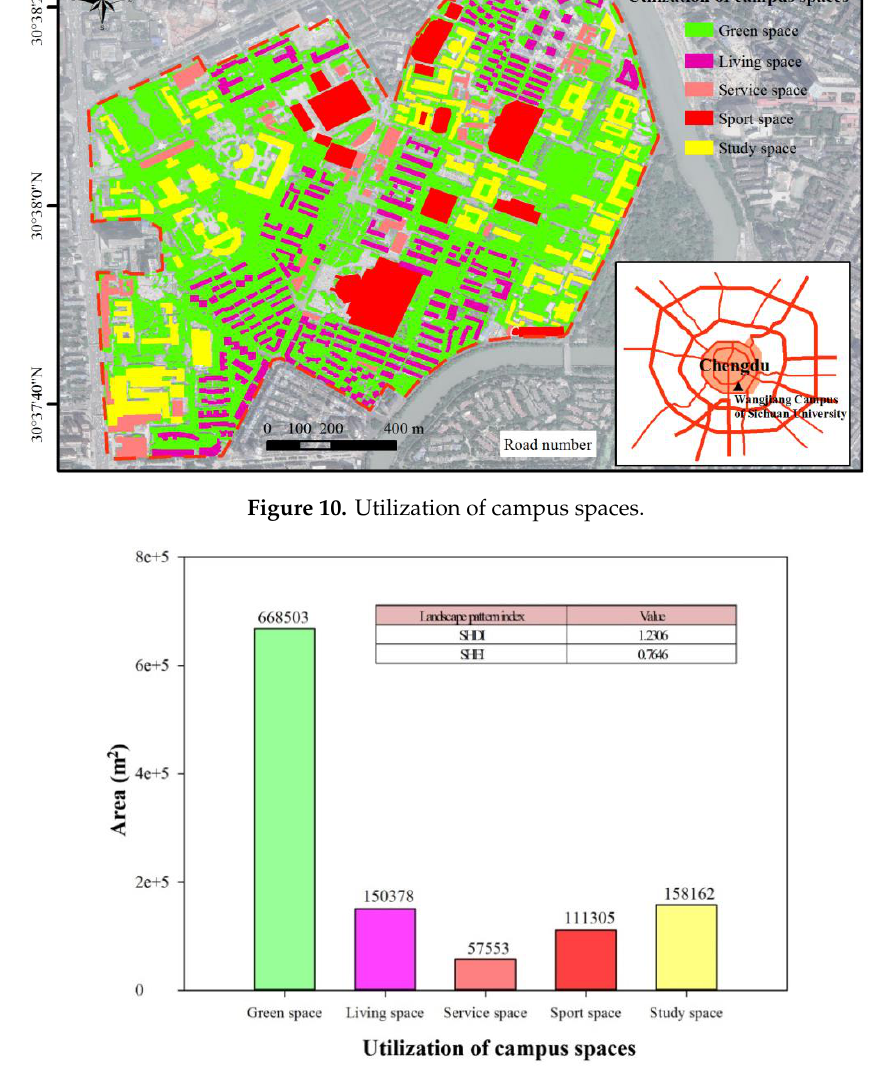
Figure 11. Area statistics of campus-space-utilization landscapes and landscape pattern index analysis.